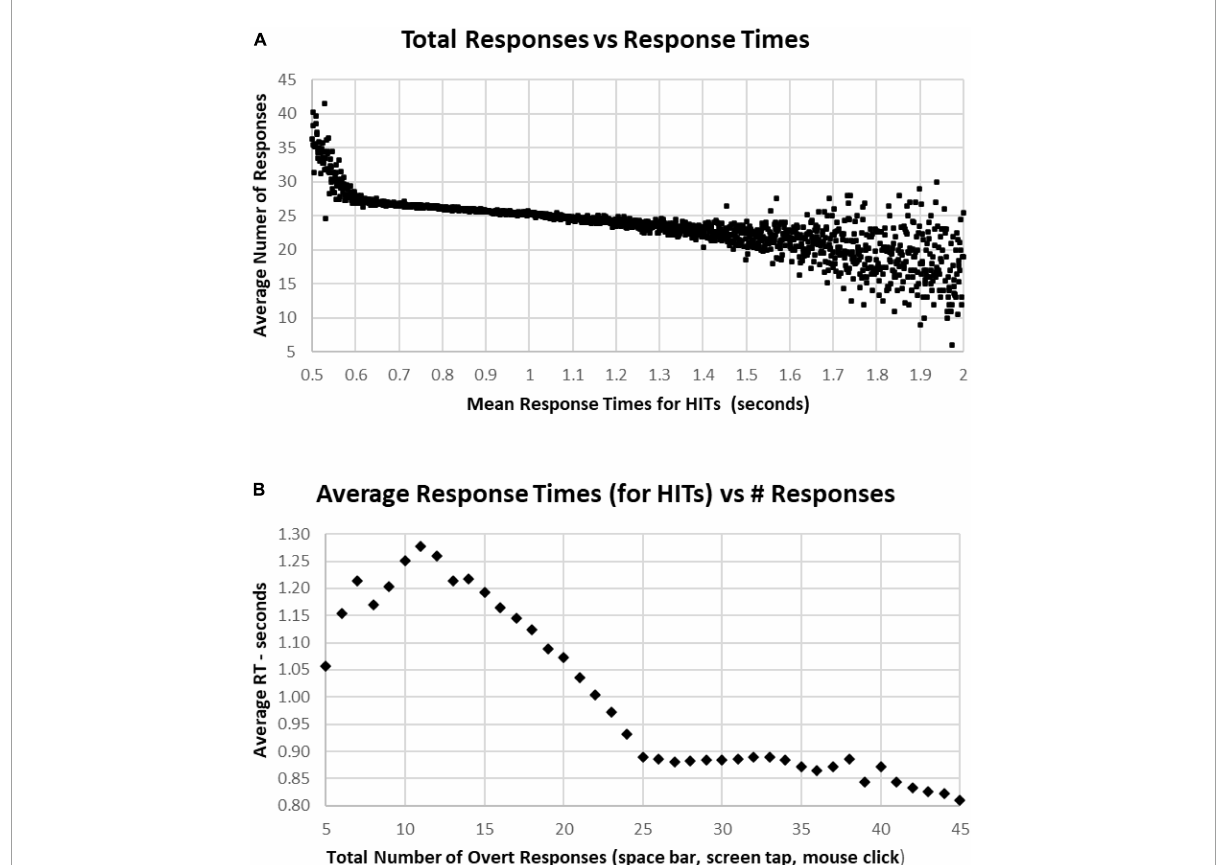
FIGURE9 (A) Average number of responses for each HIT RT, showing that there is an increase in the average under 0.600 s, while there is an increase of variability for RTs longer than 1.5 s. The discordance between number of responses and decreased RT below 0.6 s is associated with a strategy to respond more quickly, but with less discrimination. (B) Same data, averaging RTs by number of responses. Note sharp change of slope below the 25-response mark, with progressive slowing until 10 or fewer responses. But there is a stable level of RTs with an increased number of responses, suggesting that by increasing the number of false alarms, that this component of accuracy was sacrificed for